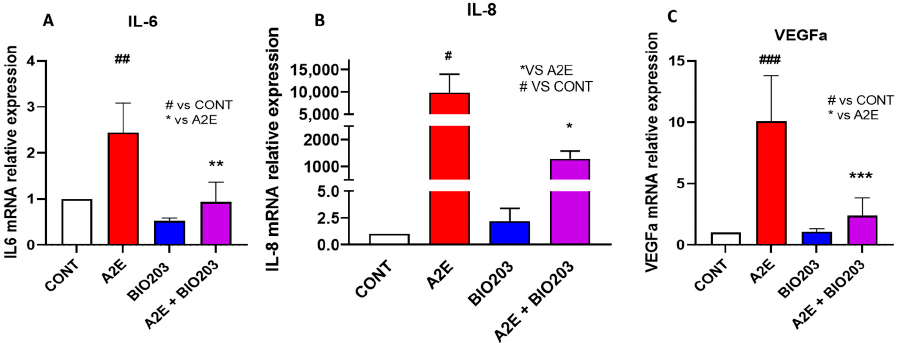
Figure 4. Effect of BIO203 (20 μ M) on IL-6 ( A ), IL-8 ( B) , and VEGF (C) expression induced by A2E (20 μ M) in RPE cells in vitro. Bars represent mean ± s.e.m. with n = 3–4 per group. # or * p < 0.05, ##